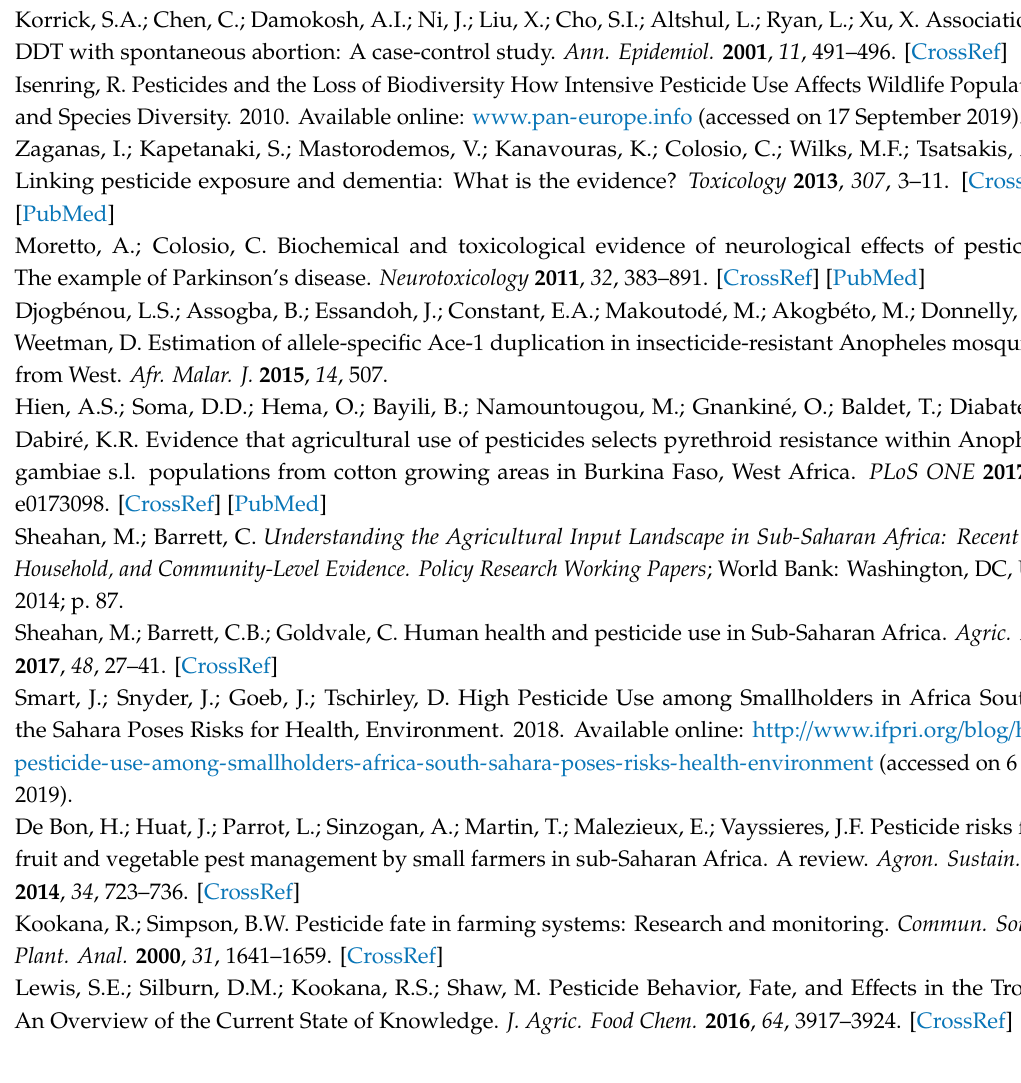
FigShare repositories, Geospatial layers on processes a ff ecting the environmental fate of agricultural pesticides in Africa [109]; Insecticide residue database for Africa [110]. Table S1. A list of variables that were used by 24 di ff erent pesticide fate models. Table S2. The number of times a variable was used in the selected 24 pesticide fate models and the processes that were mapped in this study. Table S3. Additional information on the existing geospatial datasets that were used in this study for creating maps of the processes associated with pesticide fate after spraying. Table S4. The search terms that were used to find studies that measured insecticide residues. The literature review is used to compile an insecticide residue